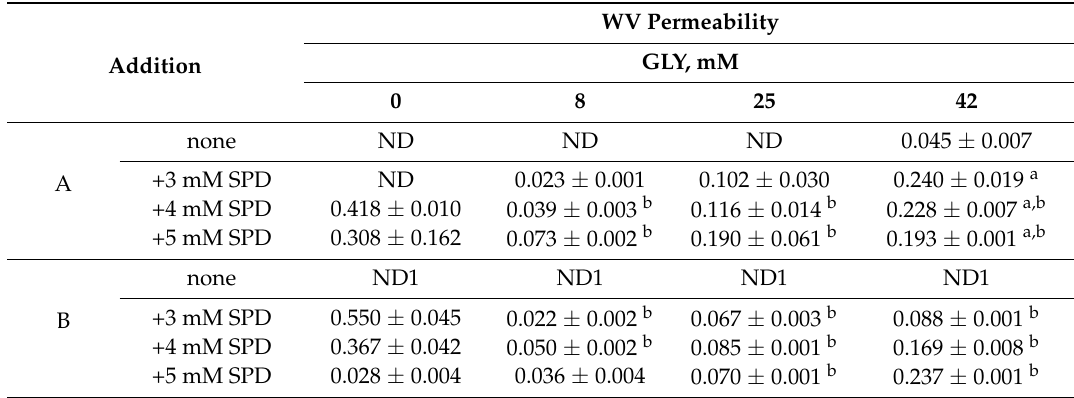
Table 5. Effect of different GLY and SPD concentrations on water vapor (WV) permeability (cm 3 mm